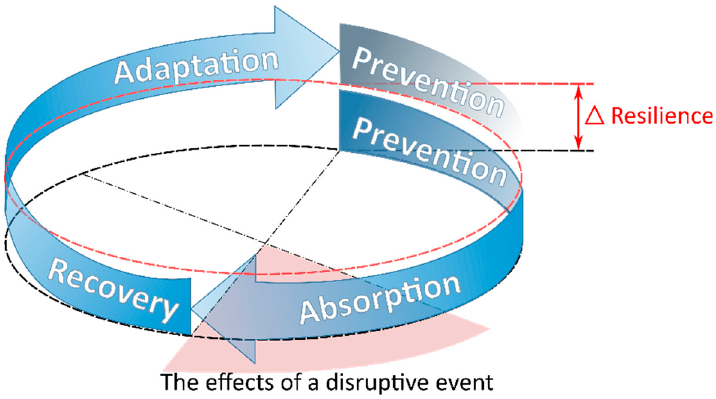
Figure 2. Critical Infrastructure Resilience Cycle (Rehak et al. 2018a).